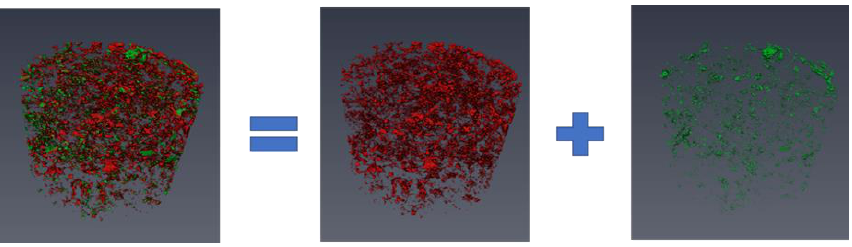
Figure 14. Y53 – 89 core after the first water flooding.